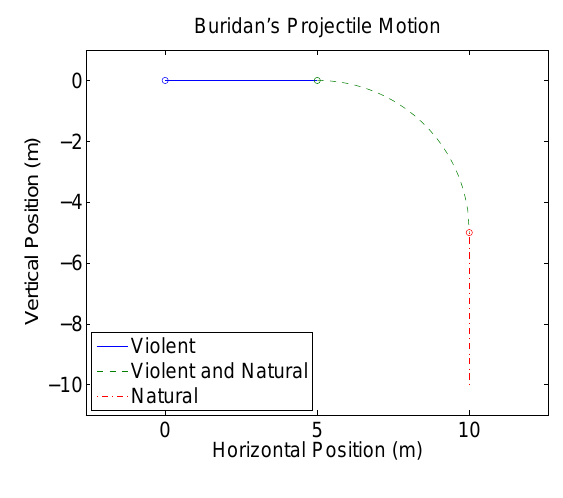
Figure 2: Albert of Saxony’s motions. and would be of infinite duration were it not diminished and corrupted by a contrary force resisting it or by something inclining it to a contrary